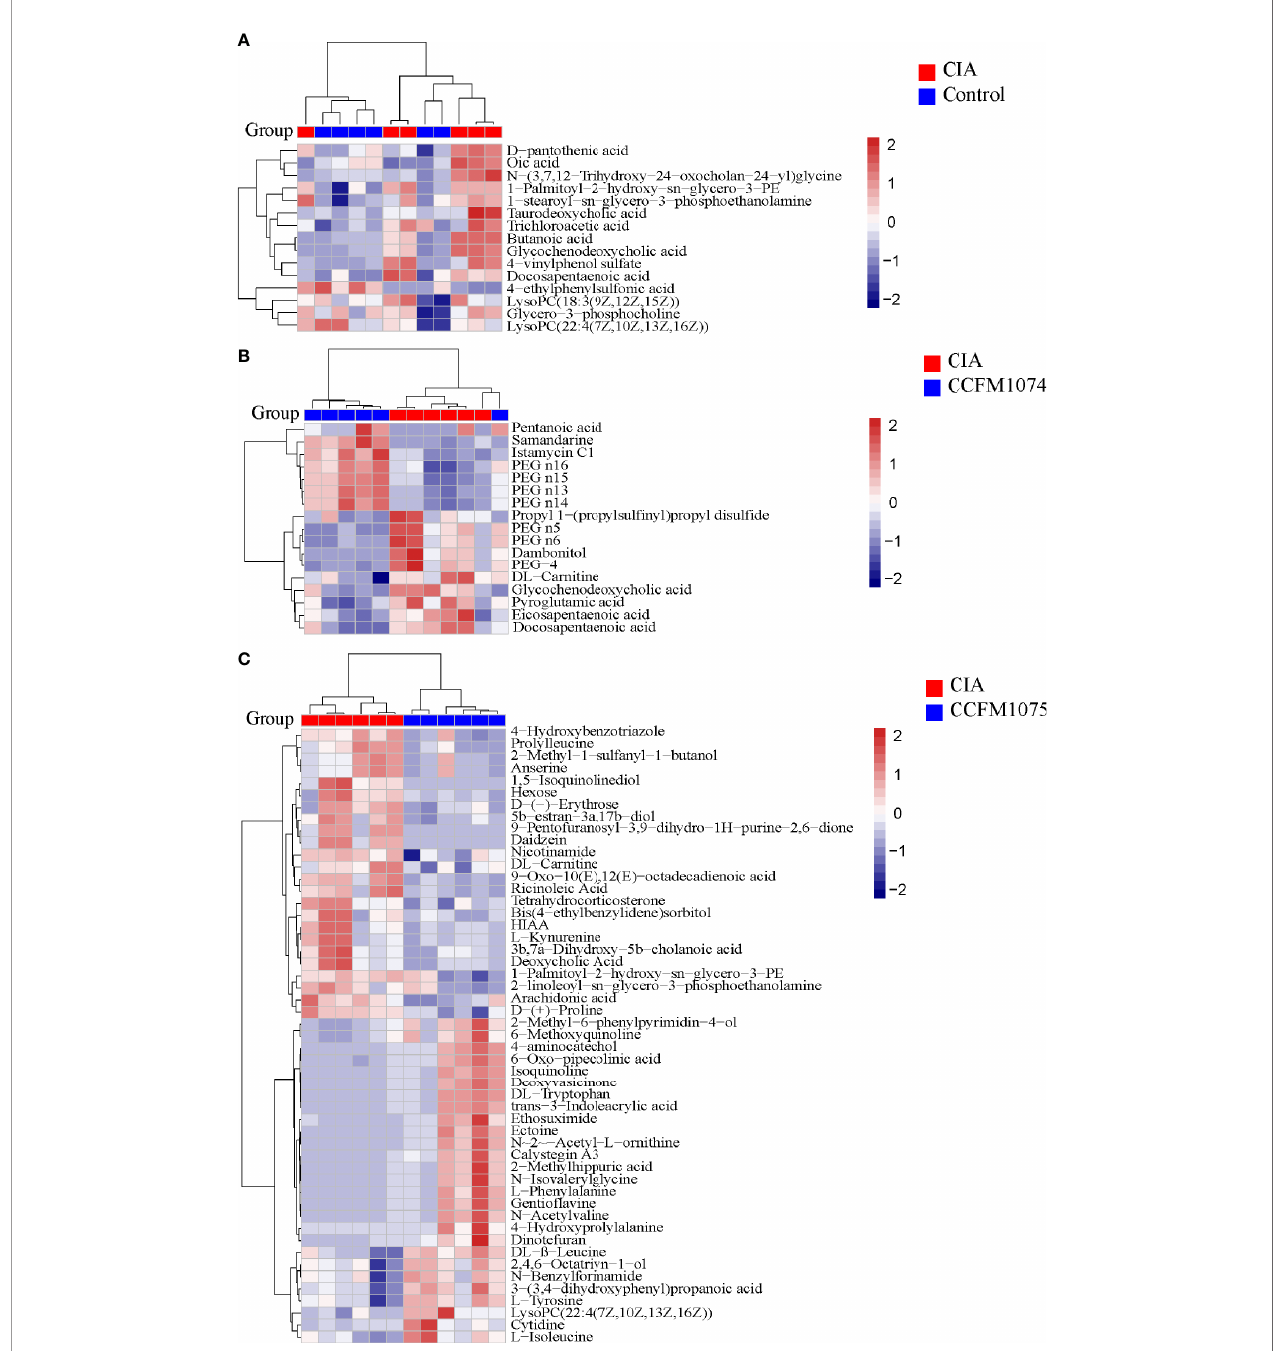
FIGURE 7 | Analyzes of differential metabolites in plasma between groups. Heat map of metabolites between CIA and Control (A) , between CIA and CCFM1074 (B) , between CIA and CCFM1075 (C) . control (vehicle-treated with saline 1.5 mL/day) group, CIA (vehicle-treated with saline 1.5 mL/day) group, methotrexate (MTX)- treated (6 mg/kg/week) group, CCFM1074 (treated with CCFM1074, 8.5 × 10 9 CFU/day) group and CCFM1075 (treated with CCFM1075, 8.5 × 10 9 CFU/day) group, eight rats per group. The differential metabolites were identi fi ed as VIP >1 and p